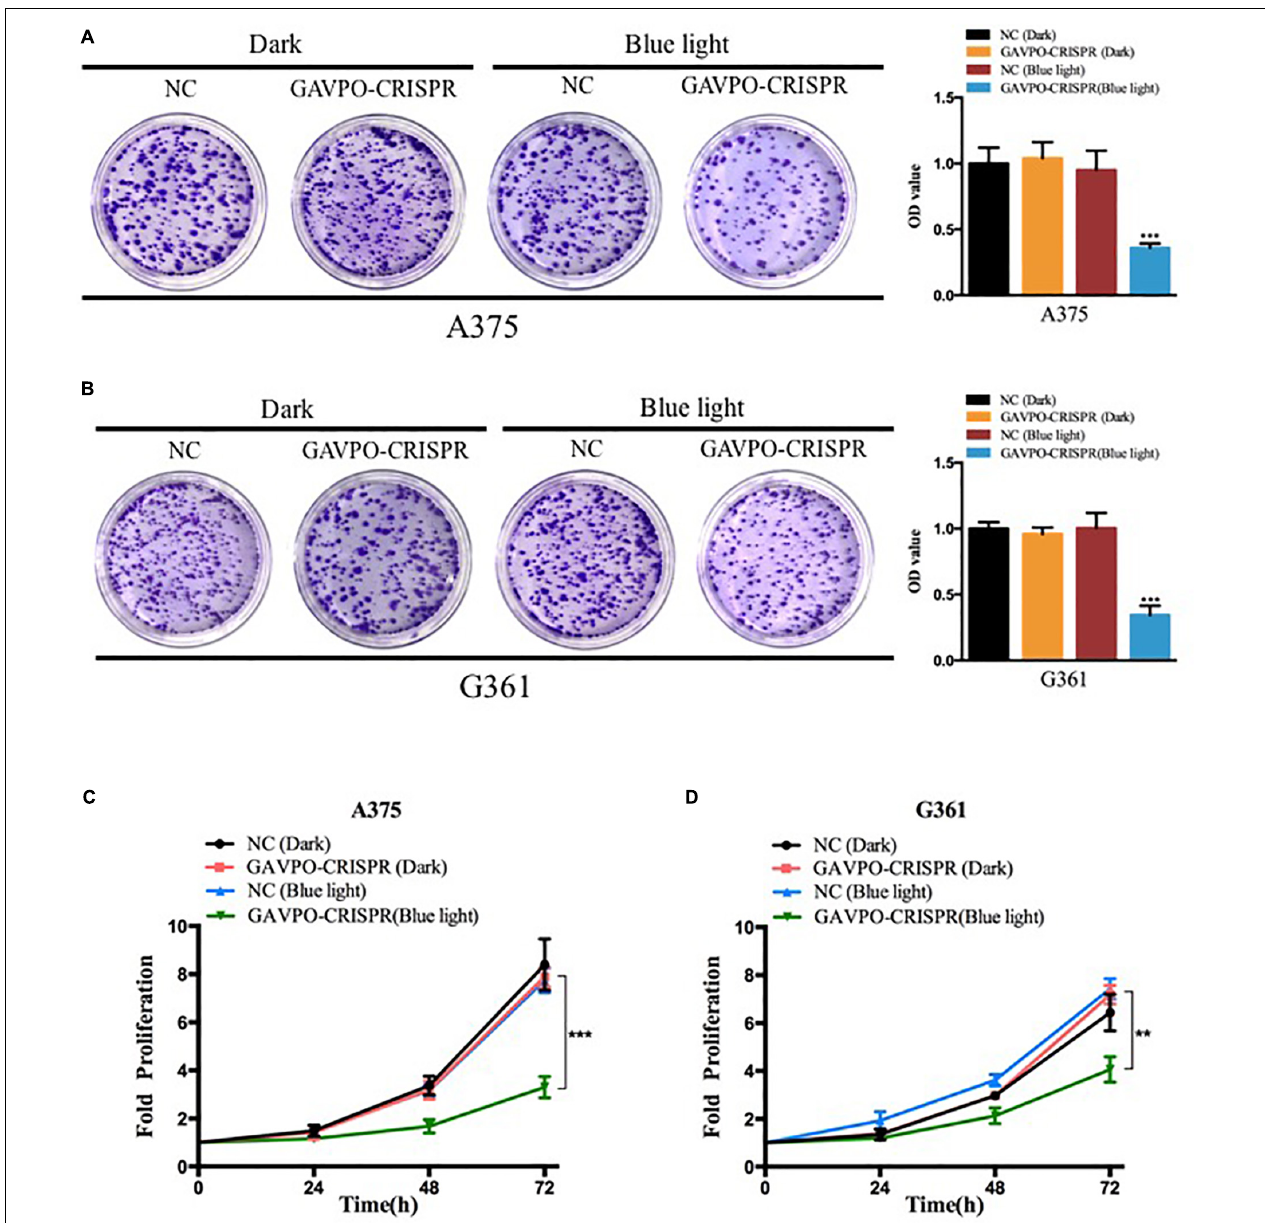
FIGURE 3 | Light-induced GAVPO-CRISPR system inhibited melanoma cell growth. (A,B) Colony-formation assay implicating the effect of light-induced GAVPO-CRISPR system under blue-light or dark conditions on cell proliferation in A375 (A) and G361 (B) cells, compared to the negative control. (C,D) CCK-8 assay representing the effect of light-induced GAVPO-CRISPR system under blue-light or dark conditions on cell proliferation in A375 (C) and G361 (D) cells, compared to the negative control. Data are presented as the means ± SD from at least three biological replicates. (* P < 0.05, ** P < 0.01, *** P < 0.001).